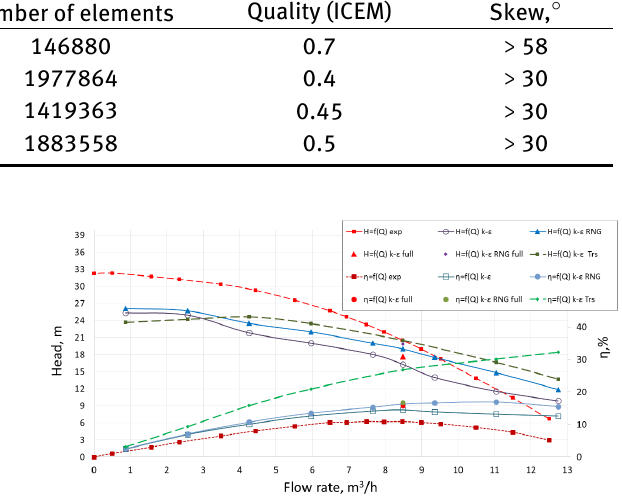
Figure 6: The comparison of the flow and eflciency characteristic obtained during he real and numerical investigations (different viscosity models, steady and unsteady simulations)